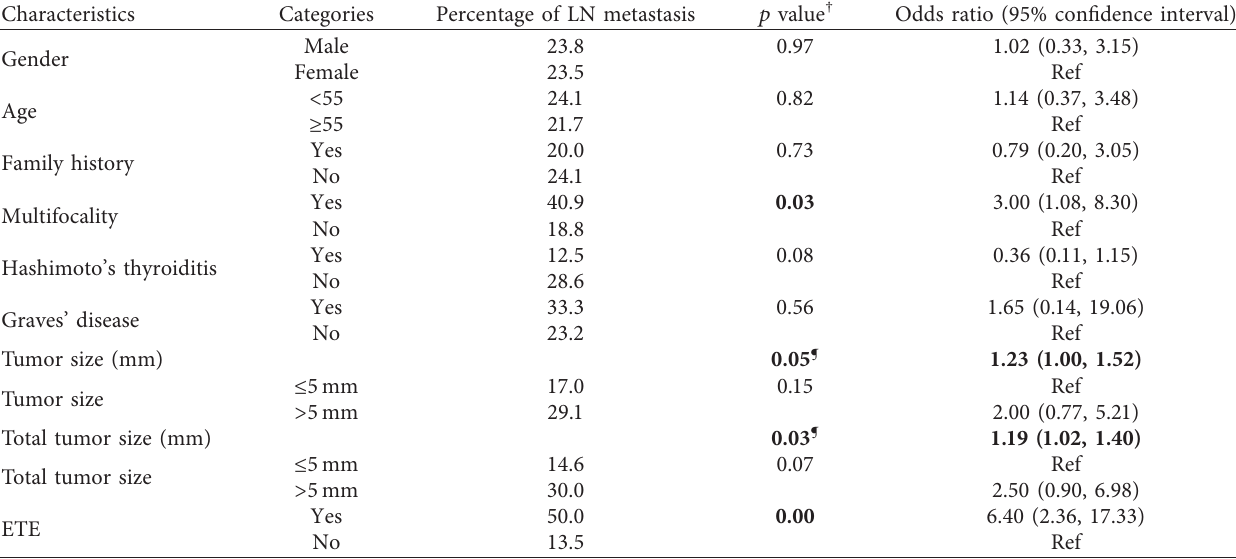
Table 4: Association between different characteristics and lymph node